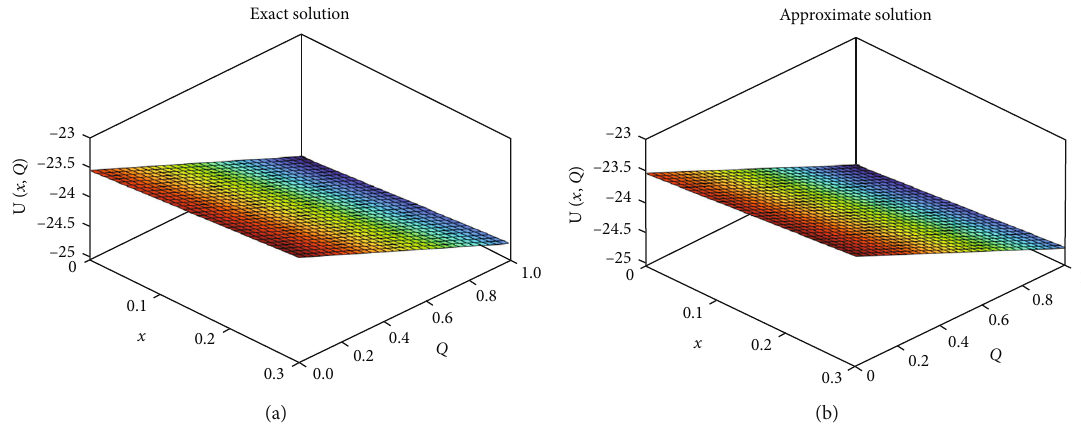
Figure 4: Three-dimensional illustration via CFD of Example 1 when δ = 1 . (a) Exact solution. (b) Approximate solution.